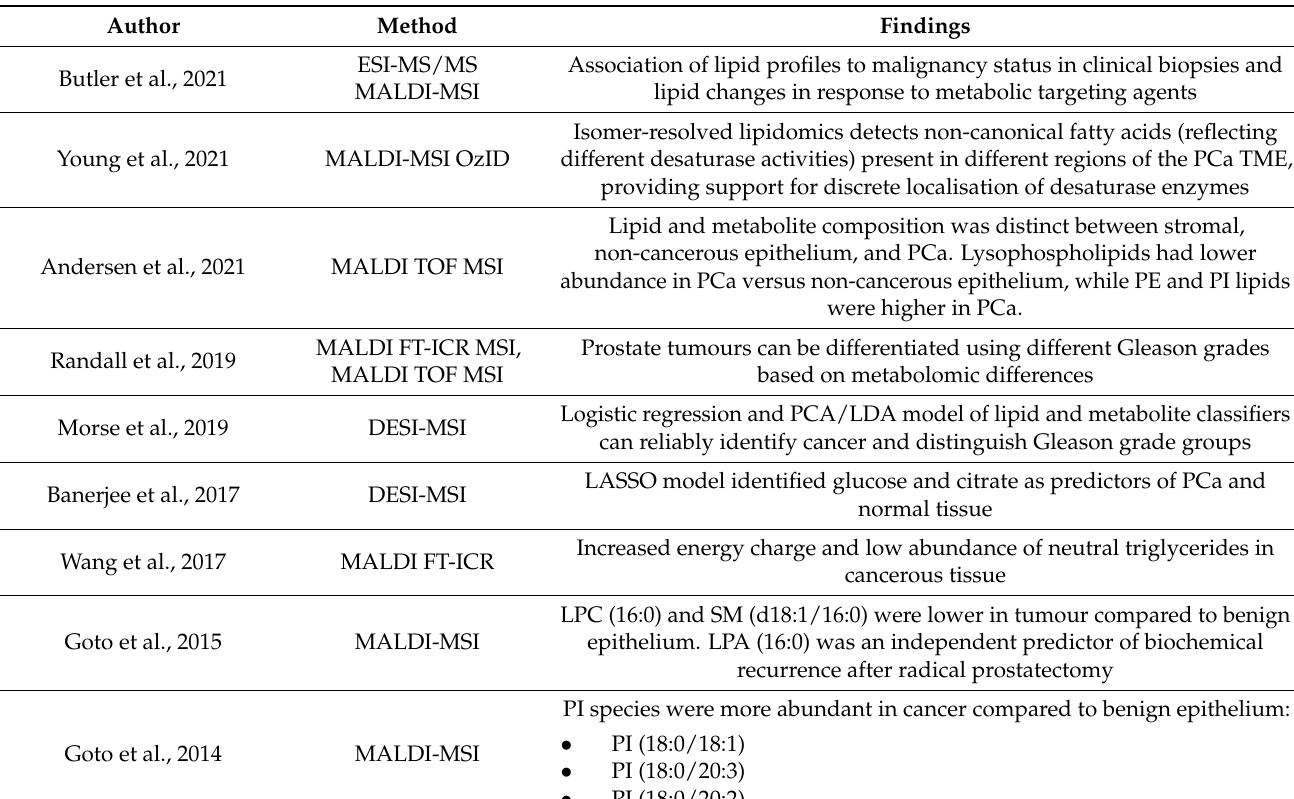
Table 1. Key studies using MSI as a spatial tool for prostate cancer metabolomics and